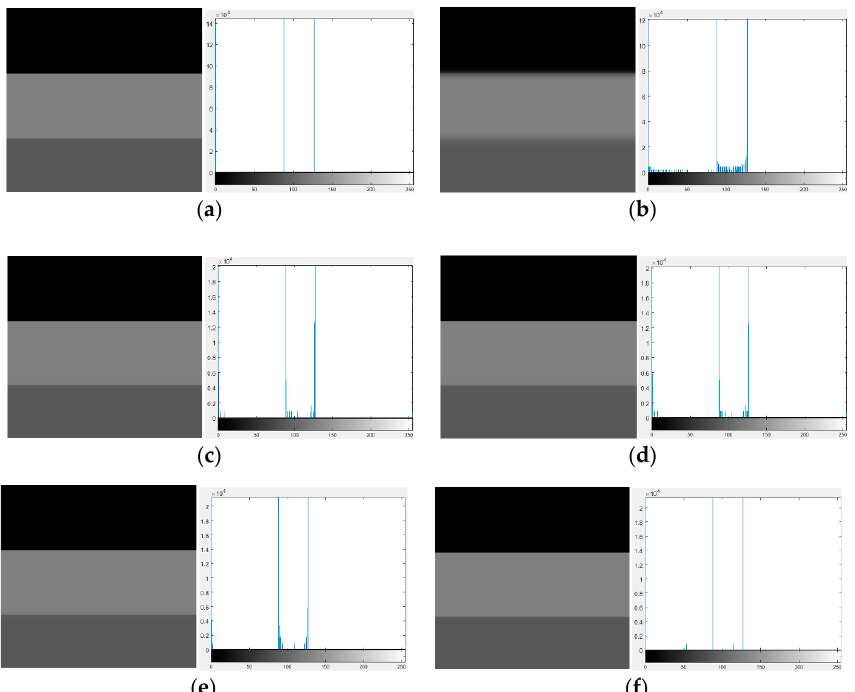
Figure 7. ( a ) Original image ( left ) and histogram ( right ). Image after implementing ( b ) GIF ( left ), with filtered histogram ( right ); ( c ) WGIF ( left ), with filtered histogram ( right ); ( d ) GDGIF ( left ), with filtered histogram ( right ); ( e ) EGIF ( left ), with filtered histogram ( right ); and ( f ) proposed algorithm ( left ), with filtered histogram ( right ). The blue line is the halo distribution of the histogram.